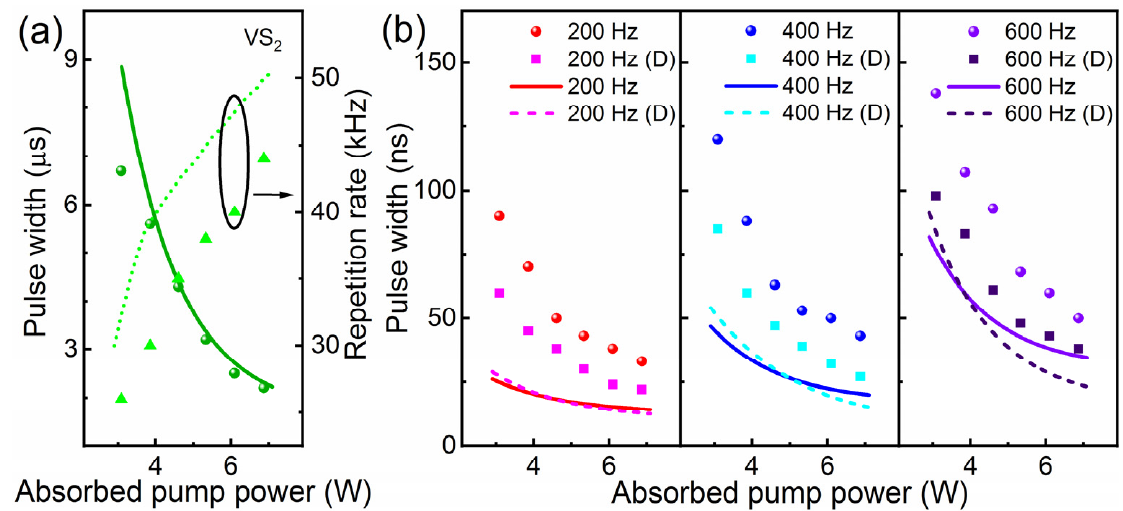
Figure 6. Relationship of absorbed pump power and pulse width (repetition rate) of (a) passively, (b) actively and doubly Q-switched lasers: symbols—experimental values, curves—simulated results.